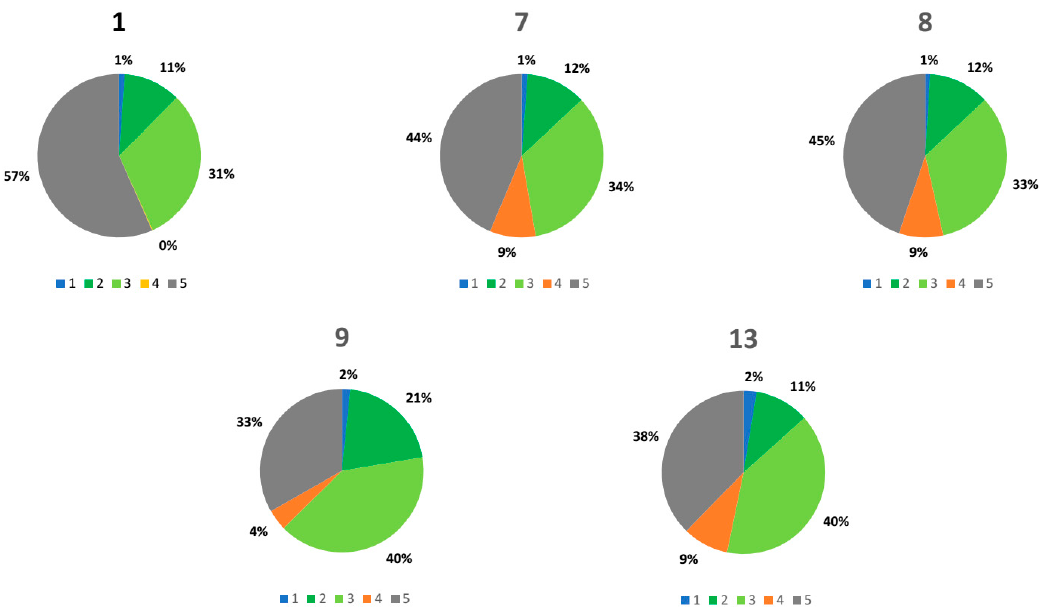
Figure 7. The pixel distribution per class for the Varaždin study area.